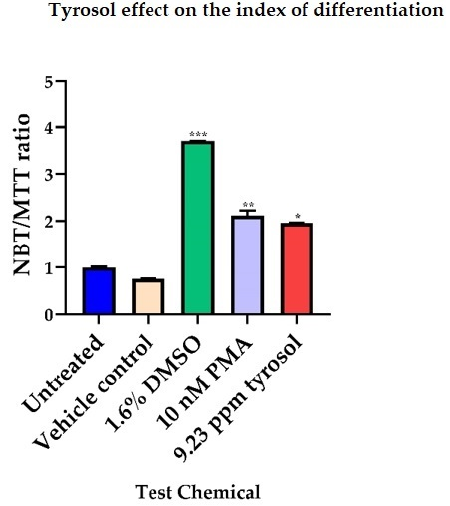
Figure 2. NBT/MTT ratio in HL-60 cells, 3 days following exposure to tyrosol. Untreated = Cells in RPMI medium, Negative control for differentiation; Vehicle control = 0.5% Ethanol; 1.6% DMSO, 10 nM PMA = Positive controls for granulocytic and monocytic differentiation, respectively. Each value is a median value where n = 9 ( n = 3 for 3 separate experiments). Values normalised to medium (RPMI) control. Error bars represent differences between the median and upper and lower quartiles. Statistically significant differences from the negative control are denoted by (*) p < 0.05, (**) p < 0.01, and (***) p < 0.001.